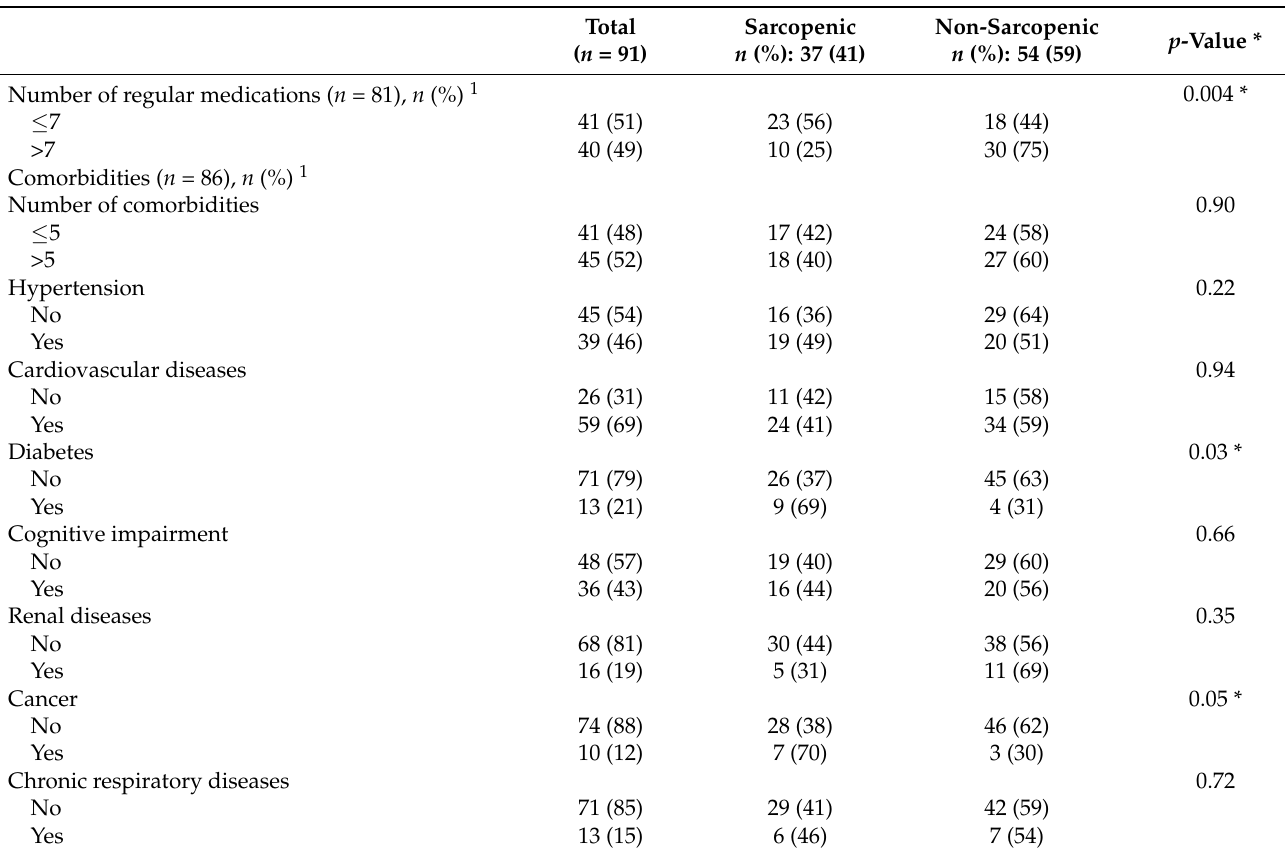
Table 2. The association of sarcopenia with medication use and